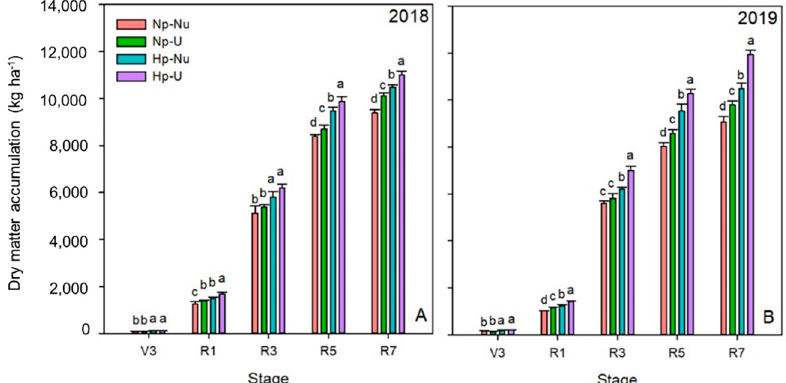
Figure 6. Effect of plant distribution on dry matter accumulation in soybean during the 2018 ( A ) and 2019 ( B ) growing seasons under different planting densities. Np, normal planting density. Hp, high planting density. Nu, non-uniform plant distribution. U, uniform plant distribution. The same letters at the same stage are not significantly different at p < 0.05 as determined by the least significance difference (LSD) test.